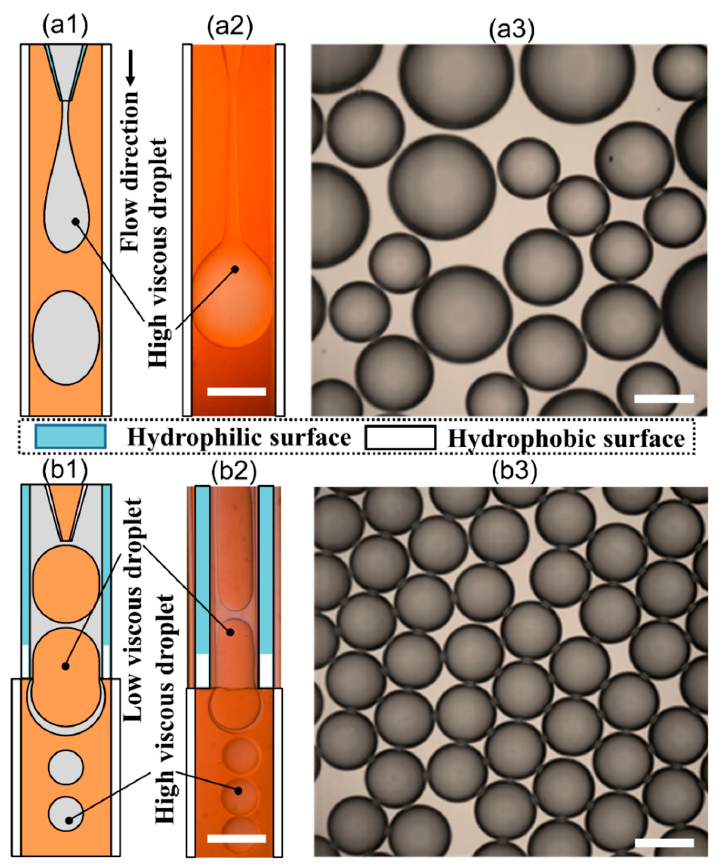
Figure 1. High-viscosity fluid in the microfluidic chip. ( a1 ) Schematic illustration of jetting mode when preparing high-viscosity microspheres using high-viscosity fluid as the inner phase; ( a2 ) Jetting mode inside the microchannel captured in high-speed camera; ( a3 ) Polydispersed high-viscosity microspheres prepared from a jetting mode; ( b1 ) Schematic illustration of dripping mode when preparing high-viscosity microspheres using the phase-inversion method; ( b2 ) Dripping mode inside the microchannel captured in a high-speed camera; ( b3 ) monodispersed high-viscosity microspheres prepared from the phase-inversion method. All scale bars are 500 µ